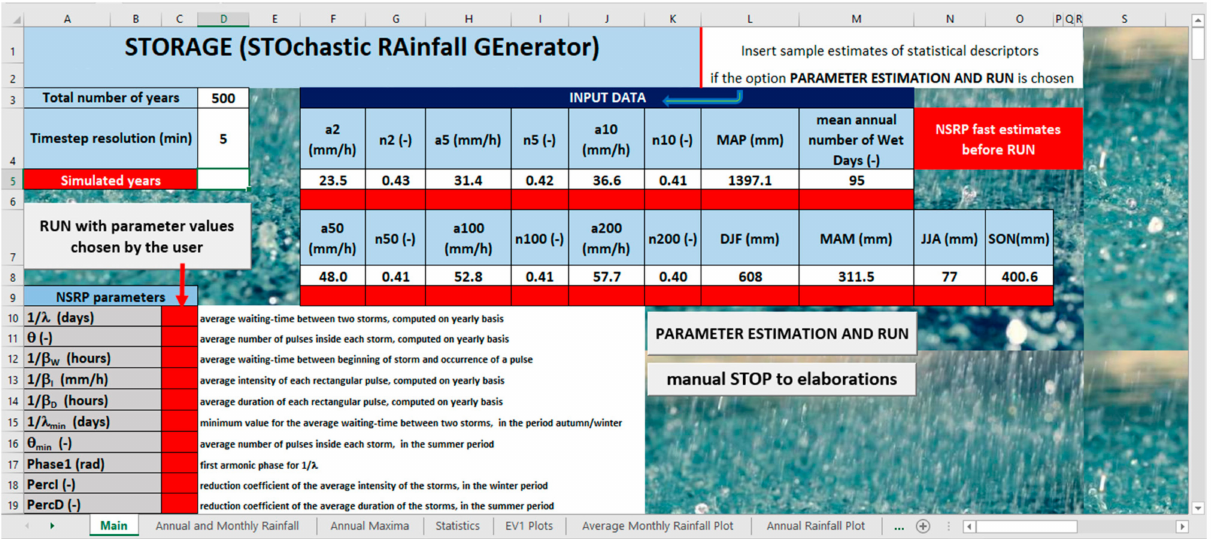
Figure 4. Example of Data Input step in the Main